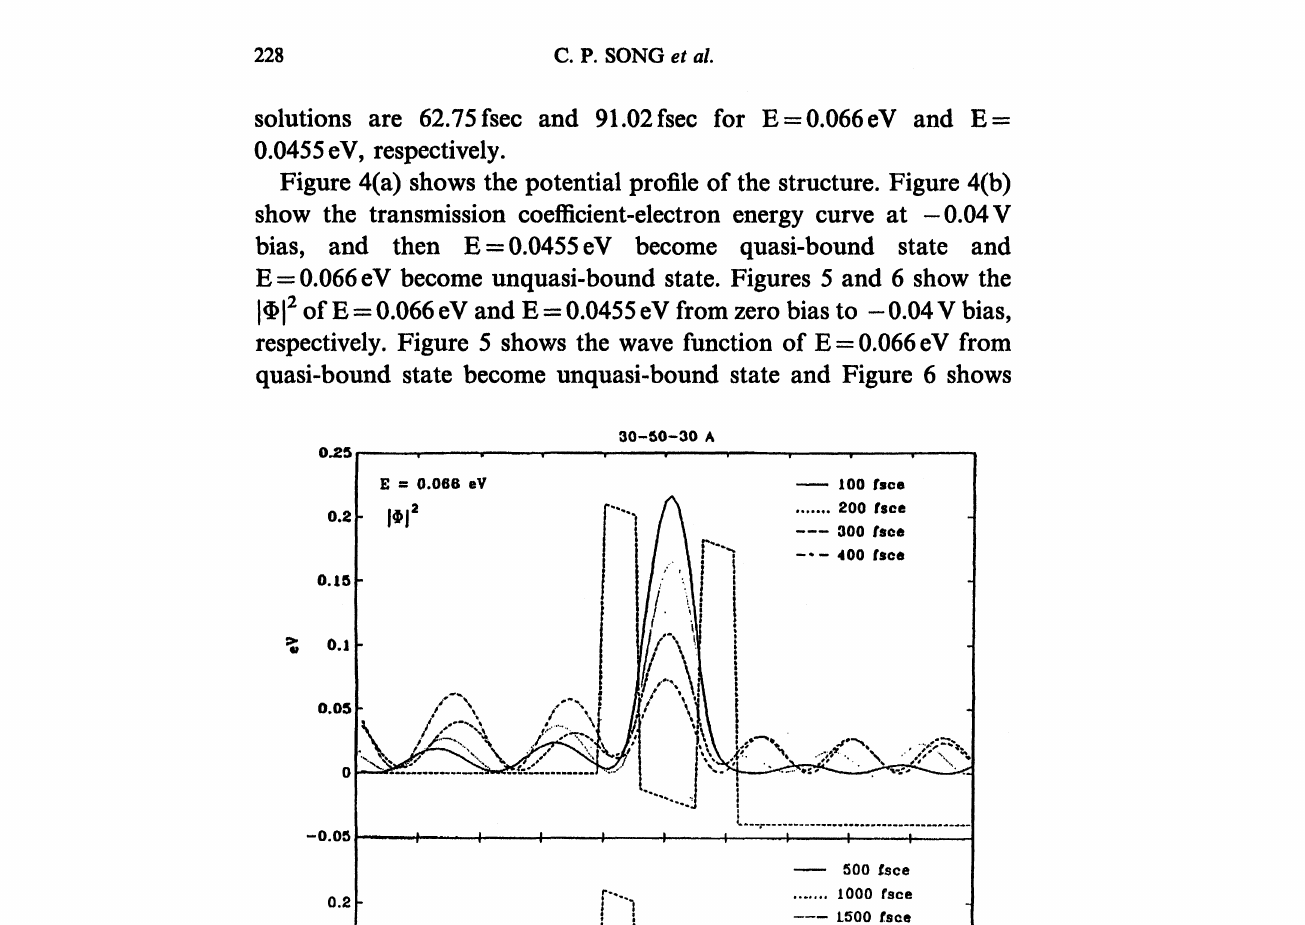
FIGURE 5 The I[ 2 of E=0.066eV varies of time at -0.04V